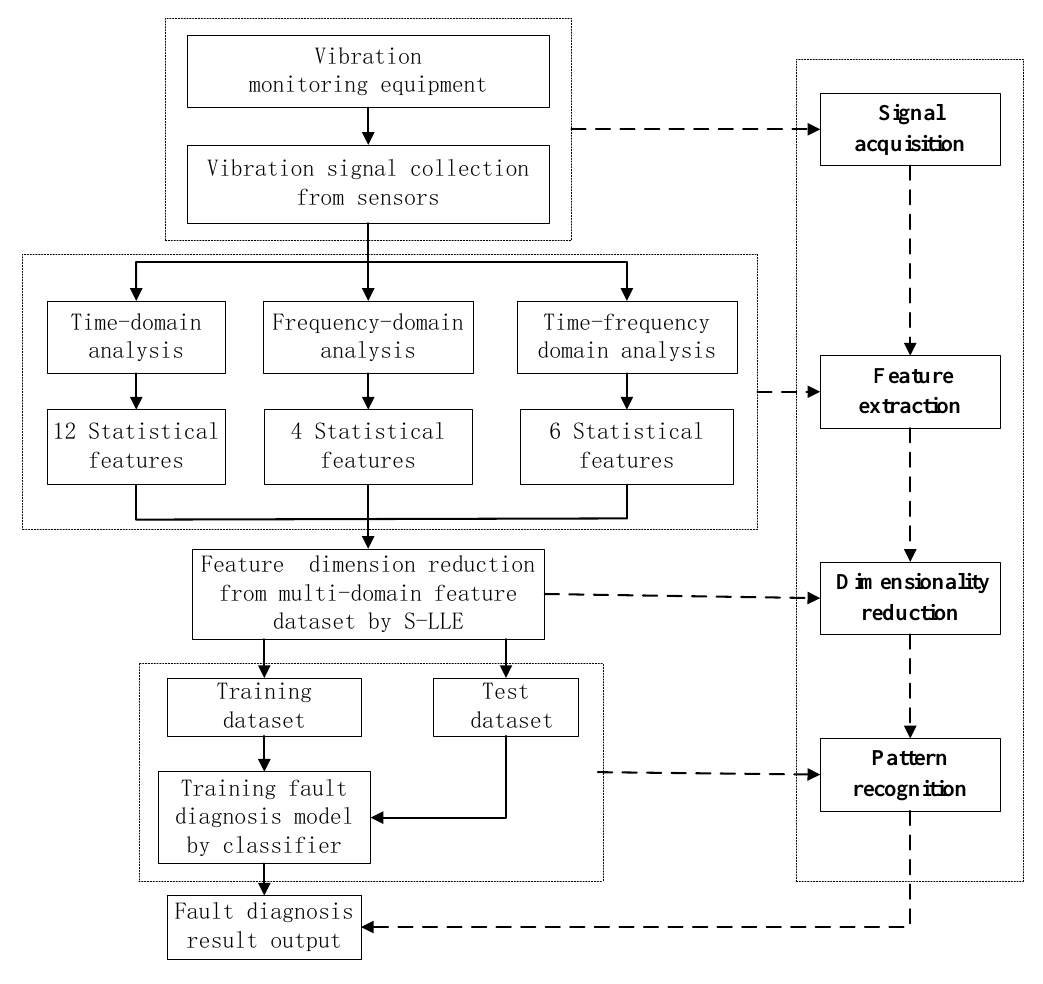
Figure 2. The implementation process and flow chart of the proposed